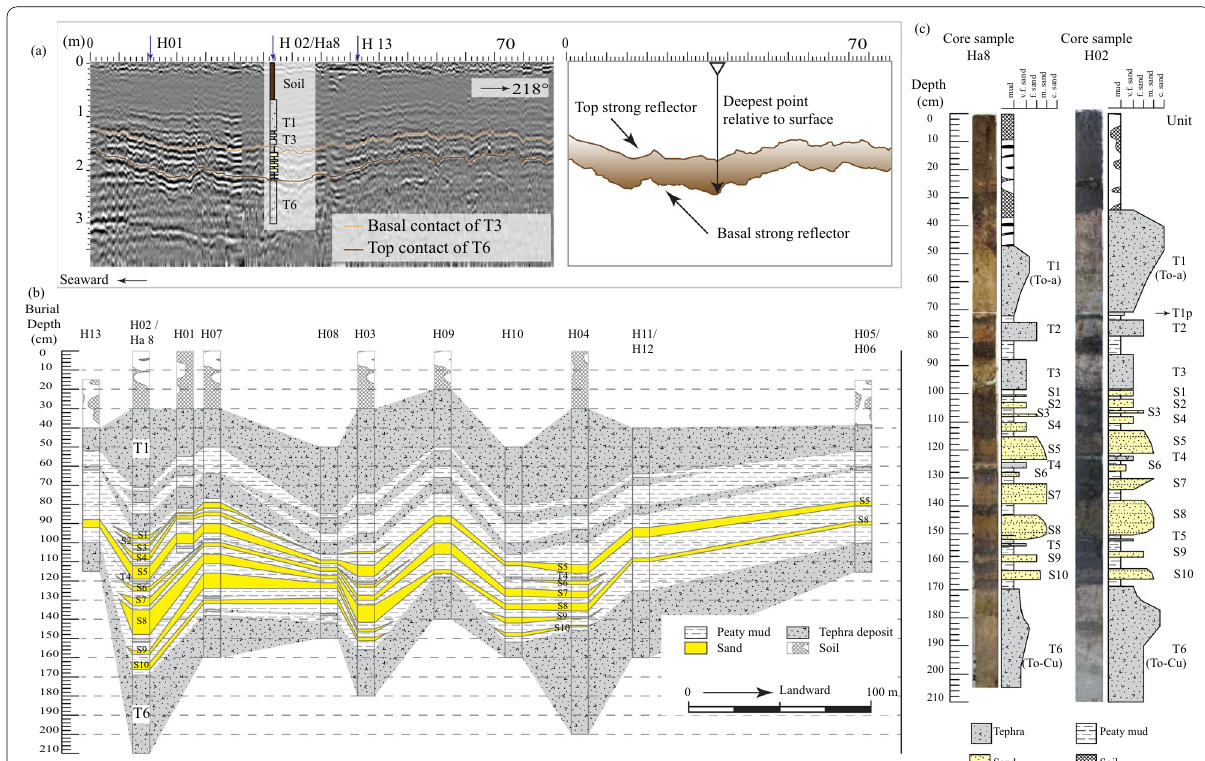
Fig. 3 a Location of core sample H02/Ha8 and relative positions of core samples H01 and H13on the GPR profile. Note that core samples H01 and H13 are displaced laterally from the GPR line (Fig. 1b). b Relative position of horizontal core sample and sand events correlation, based on sedimentary features and stratigraphic relationships. c Stratigraphic column of core samples Ha8 and H02, separated laterally by